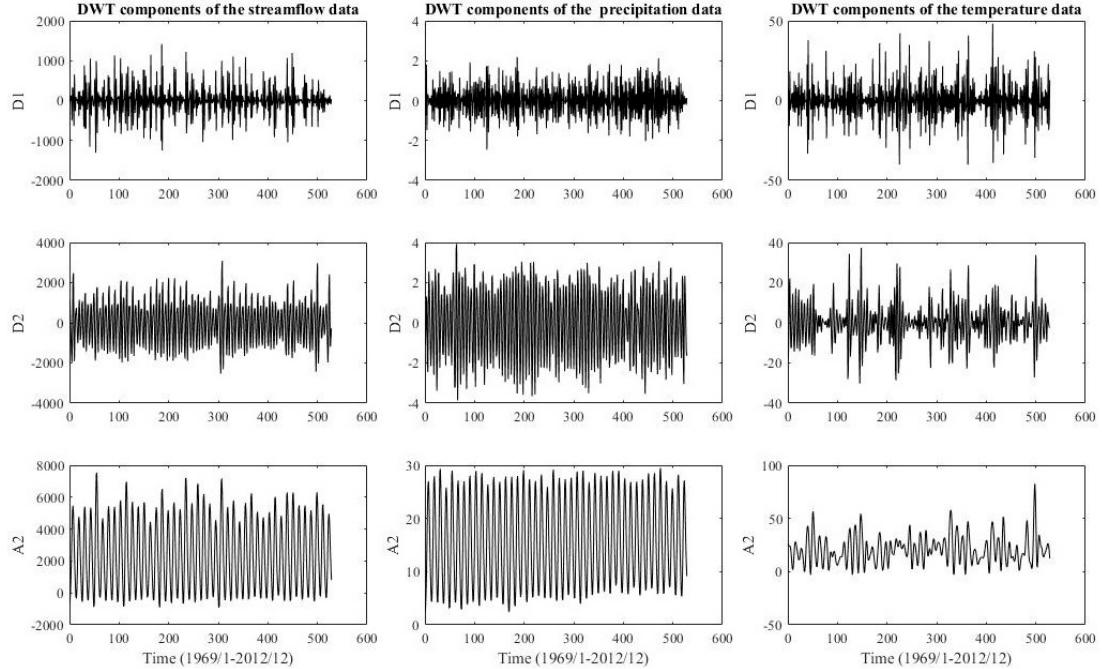
Figure 5. Zone Two: streamflow, precipitation, and temperature data are decomposed by DWT.